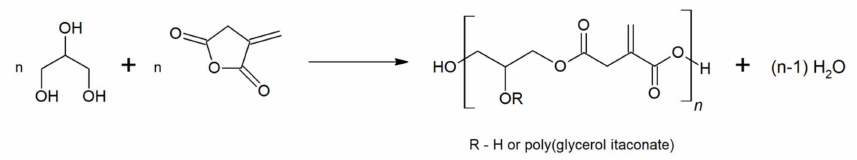
Figure 13. Synthesis of PGItc from glycerol and itaconic anhydride.